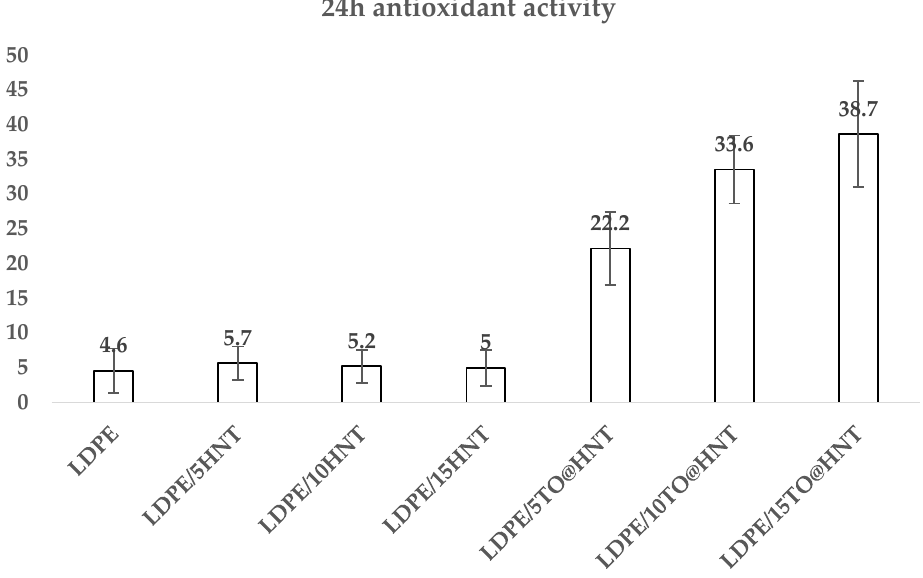
Figure 9. Antioxidant activity values after 24 h incubation for all LDPE/xHNT, LDPE/xTO@HNT films, as well as pure LDPE film.